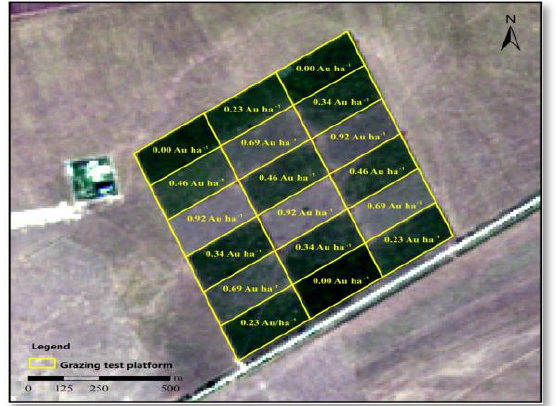
Figure 1. Geographic location of the study site and design diagram of different cattle grazing intensities. The values 0.00, 0.23, 0.34, 0.46, 0.69, and 0.92 AU ha − 1 correspond to different livestock rates (1 AU = 500 kg of adult cattle). Stocking rates were achieved using 0, 2, 3, 4, 6, and 8 young cattle (250–300 kg) per plot.